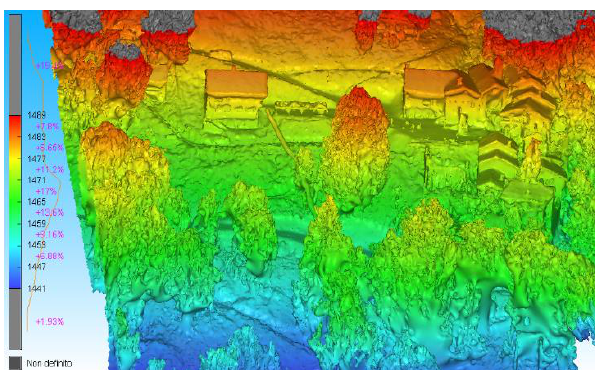
Figure 8A screen shot of the oriented images in the area of